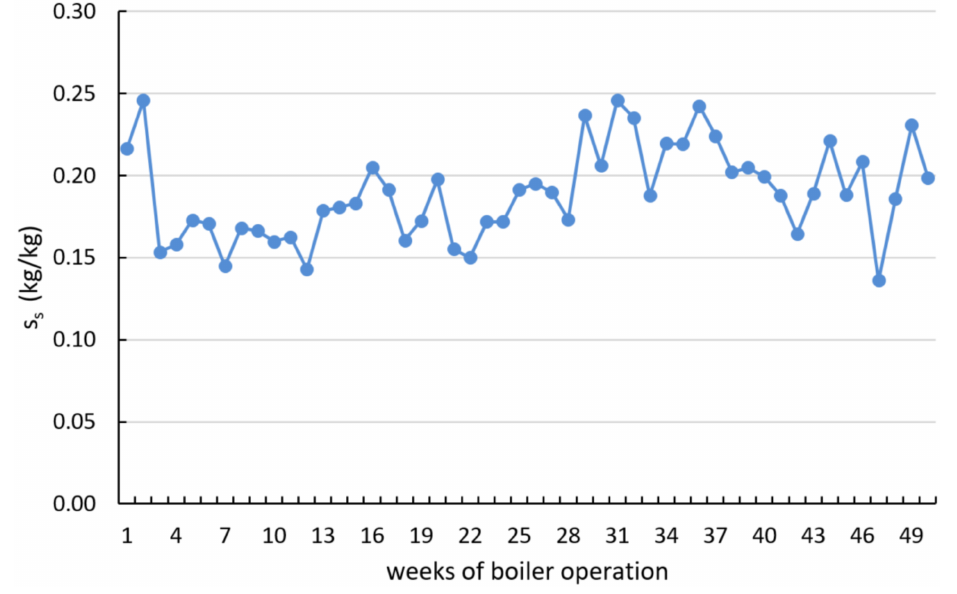
Figure 8. Unitary slag volume s s